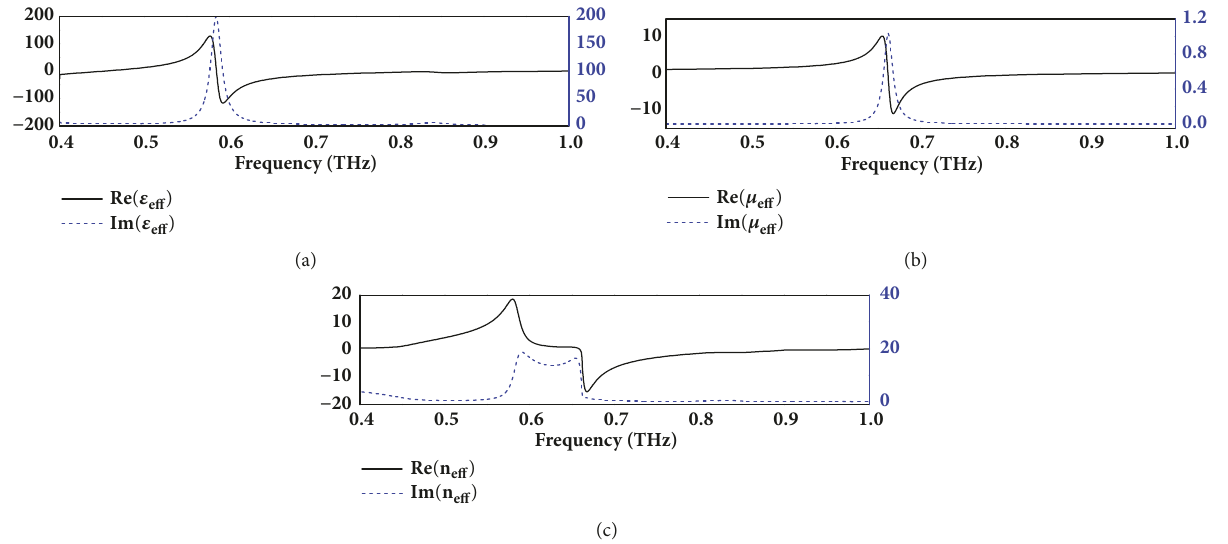
Figure 2: The numerical results of the real part (Re) and imaginary (Im) part of 𝜀 𝑒𝑓𝑓 , 𝜇 𝑒𝑓𝑓 , 𝑛 𝑒𝑓𝑓 of the composite DS/NPH effective metamaterials.